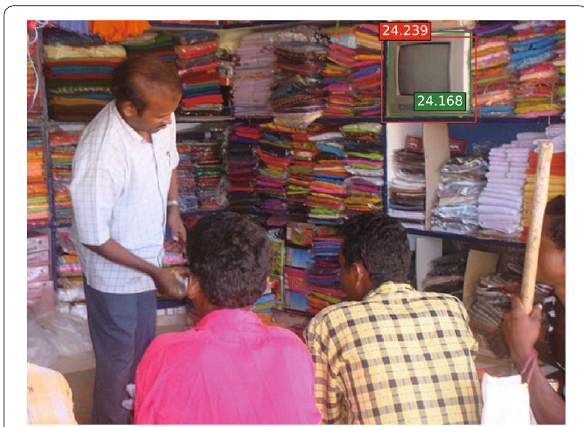
Fig. 10 Examples of results in Pascal3D TV monitor. The ground truth distance and estimated distance are written in green and red boxes respectively. The unit of distance is based on CAD models